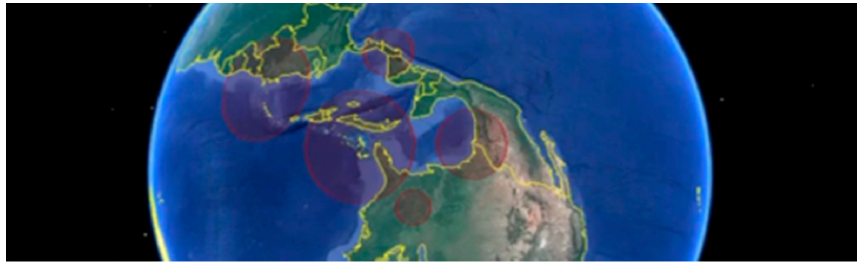
Figure 7. Generated spatial clusters are translated into a .kml file, and visualized in Google Earth software.